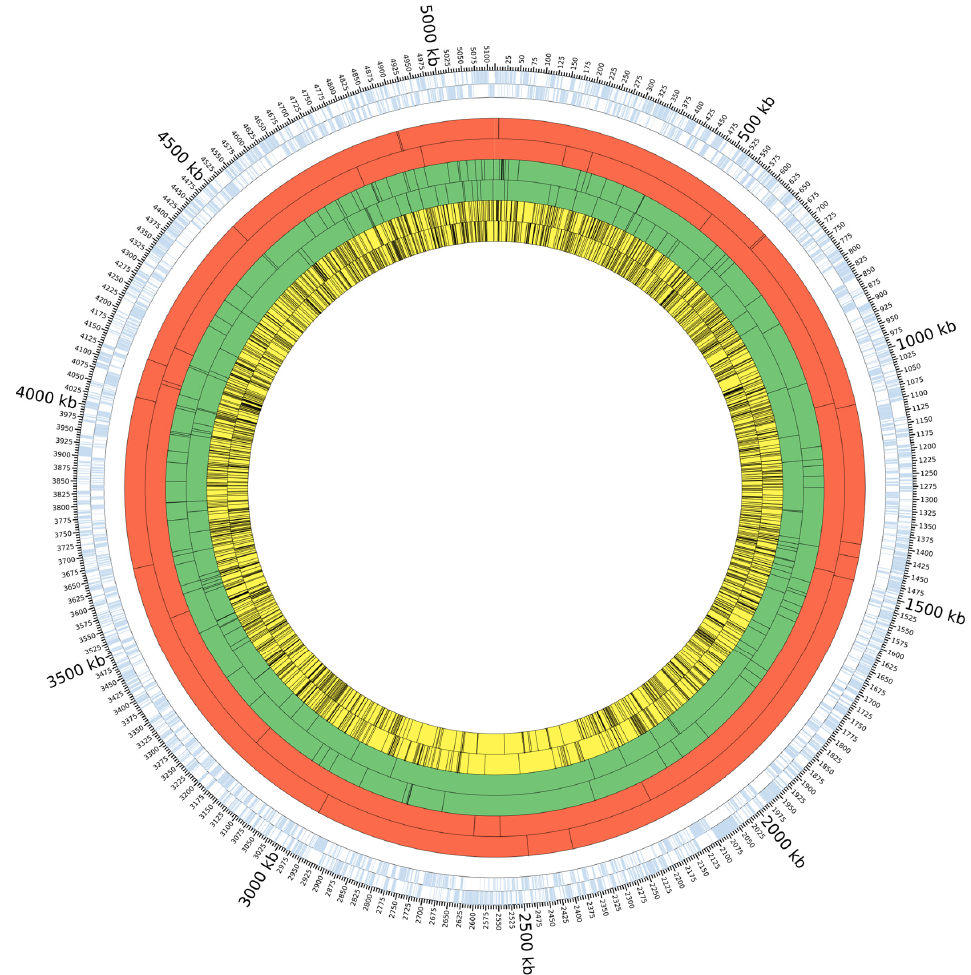
Figure 2. Circos plot of the results of the methylation analysis. Starting from the outside, plotted tracks represent the location of E. coli ATCC 35218 CDSs (light blue); the methylation status of A in the dam patterns (red); the methylation status of C in the dcm patterns (green); and the methylation status of C in CpG patterns (yellow). For methylation sectors, the direction (up/down) of bars indicates the strand where methylation has been called. Table 1. Cytosine methylation state of E. coli TOM and relative gene expression in tomato pericarp. Gene